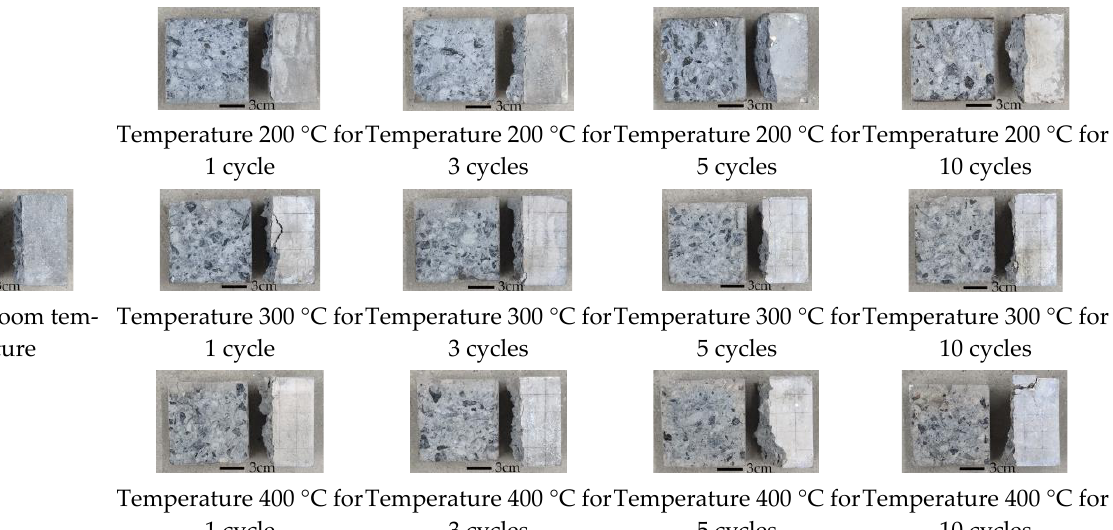
Figure 7. Splitting section characteristics of magnetite concrete at high temperature with repeated heating.